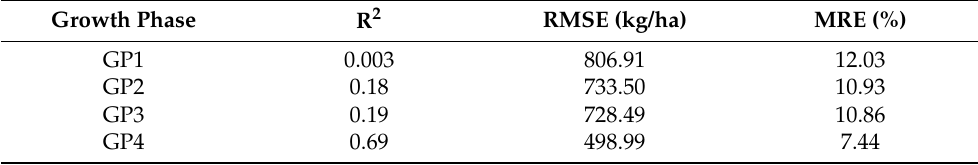
Table 5. Performances of the yield forecast models of a single growth